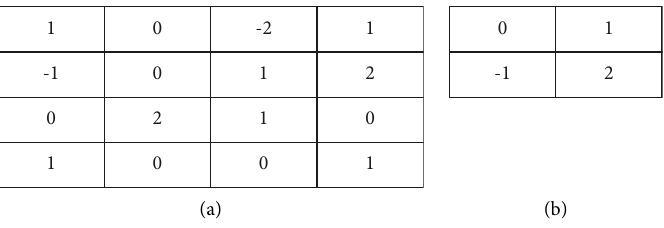
Figure 3: The input image with the kernel: (a) 4